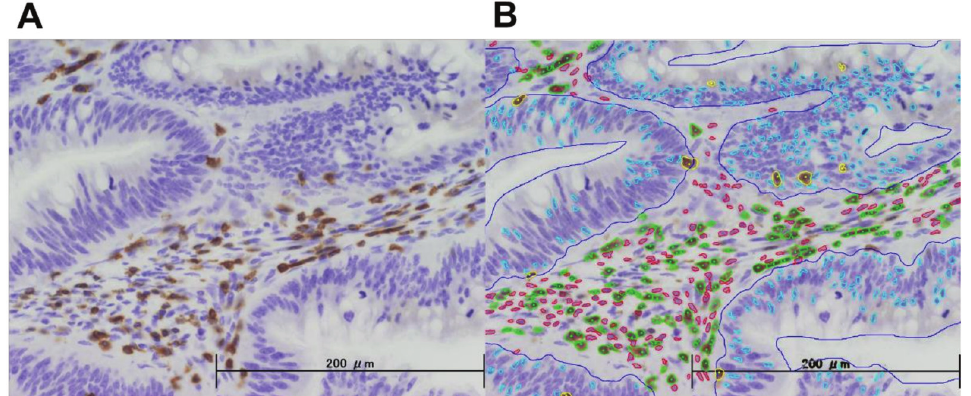
Figure 1. A typical staining pattern of well-differentiated adenocarcinoma in a patient with colon cancer. ( A ) Immunohistochemical staining with anti-CD3 antibody. Brown cells = CD3+ cells. ( B ) The images were analyzed using semi-custom image analysis software. Blue line = boundary between peri-cancerous stromal area and intra-cancerous area within the tumor. Green cells = CD3+ cells infiltrating in tumor stroma. Yellow cells = CD3+ cells on top of the cancer cells. Other cells including those showing red and sky-blue colors were not